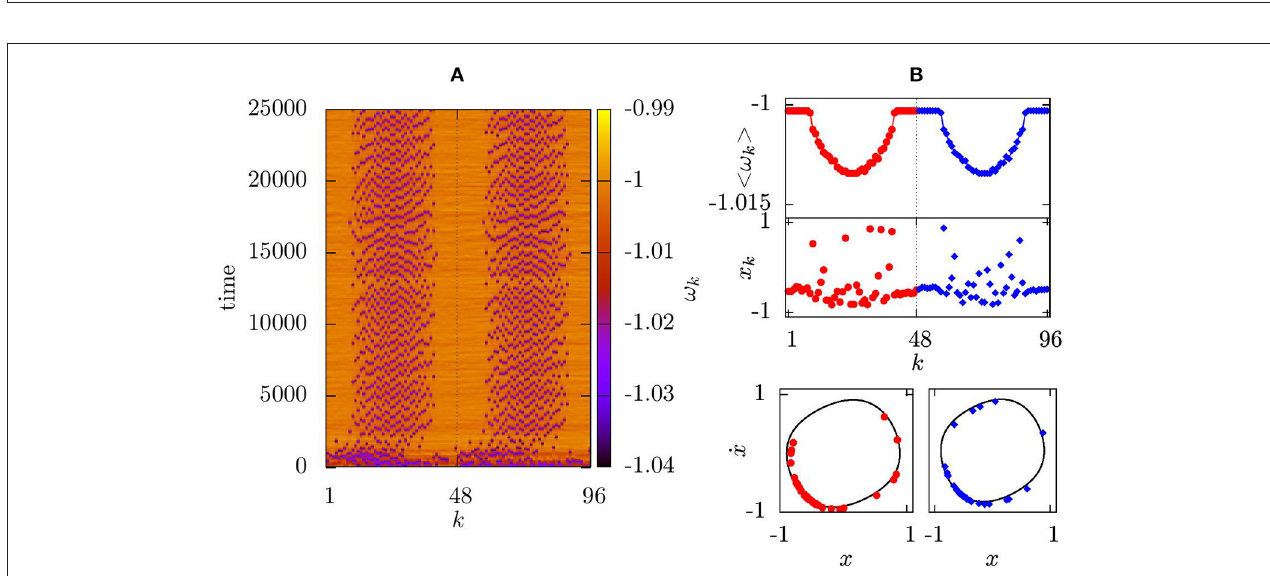
FIGURE 5 | Space-time plot of the mean phase velocities for a two-layer network with one part of the control switched off; (A) drifting chimera state in both layers with K a = 0; (B) collapse of the uncontrolled chimera state in both layers, with constant coupling coefficients σ (1) ± = 0.14. Other parameters as in Figure 3 .